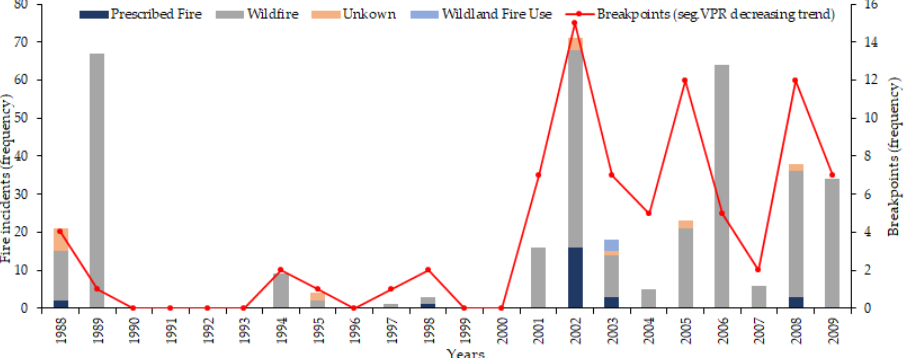
Figure 11. Timeseries of breakpoints concurrent different types of fire incidents in New Mexico during the 1984–2015 period.